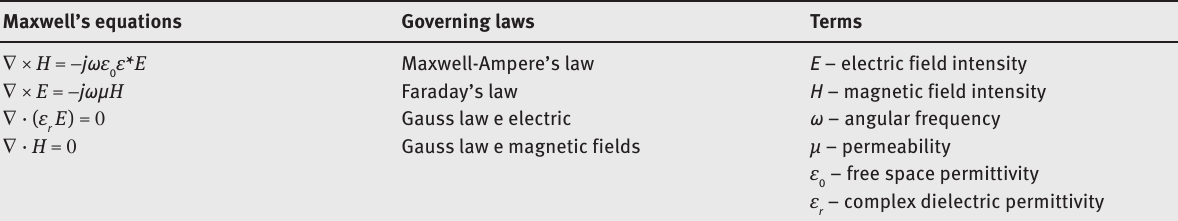
Table 2: Maxwell’s